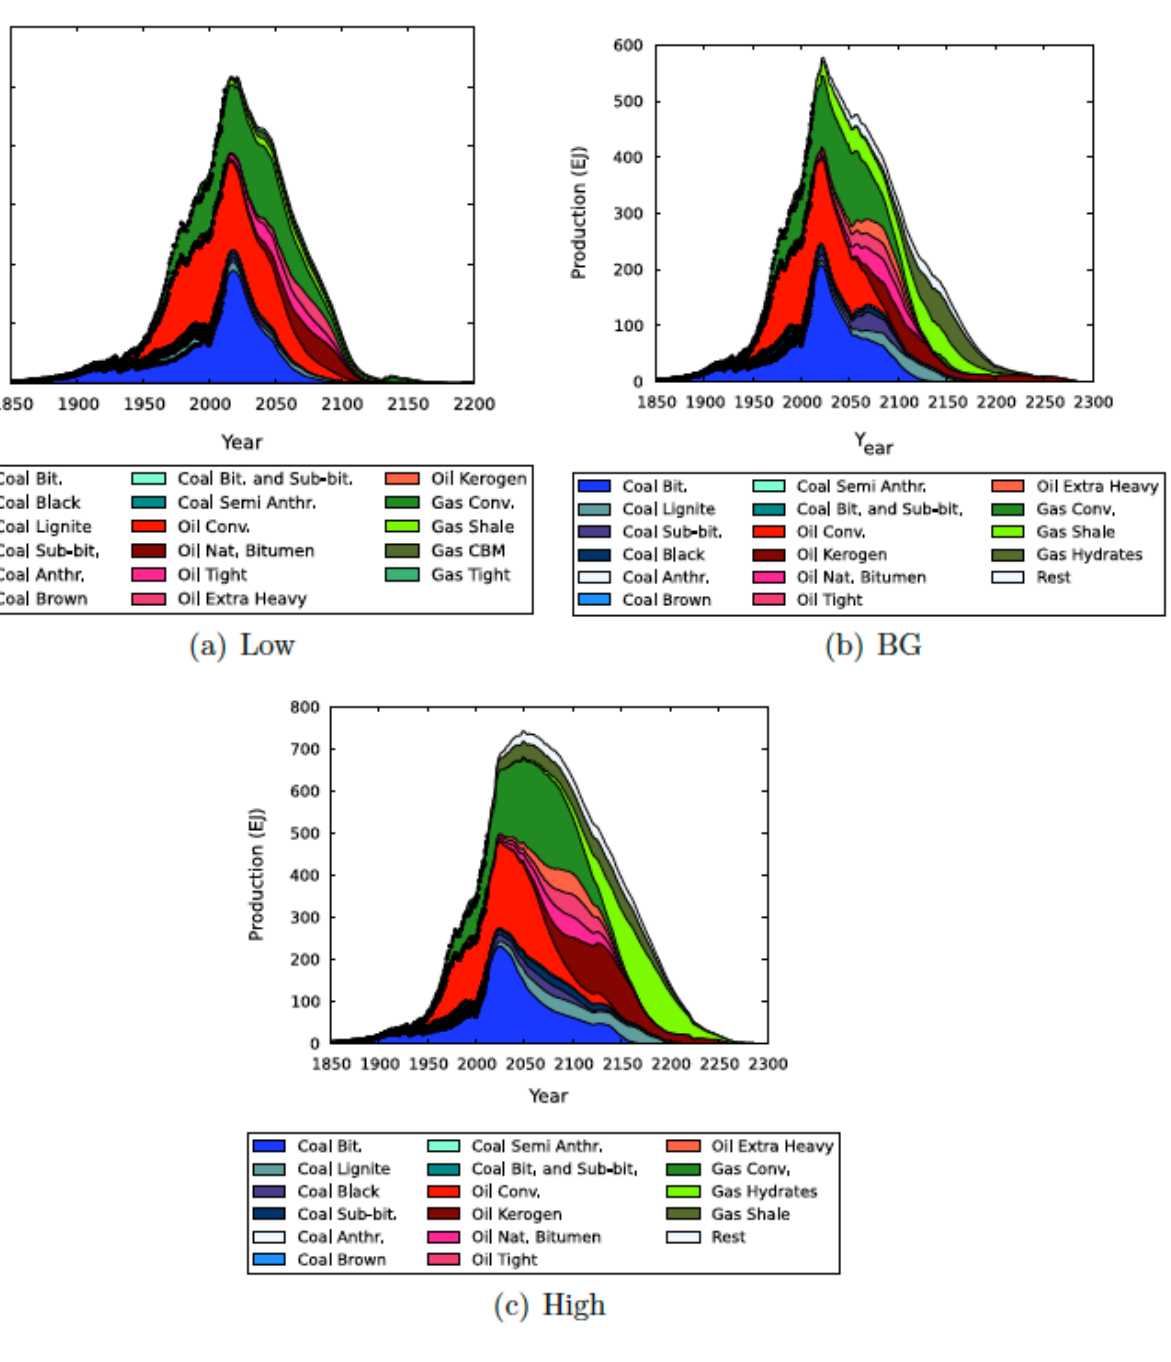
Figure 3. Predictions of future production of all fossil fuels under the assumption of low, medium and high estimates of all resources [22]. and high estimates of all resources